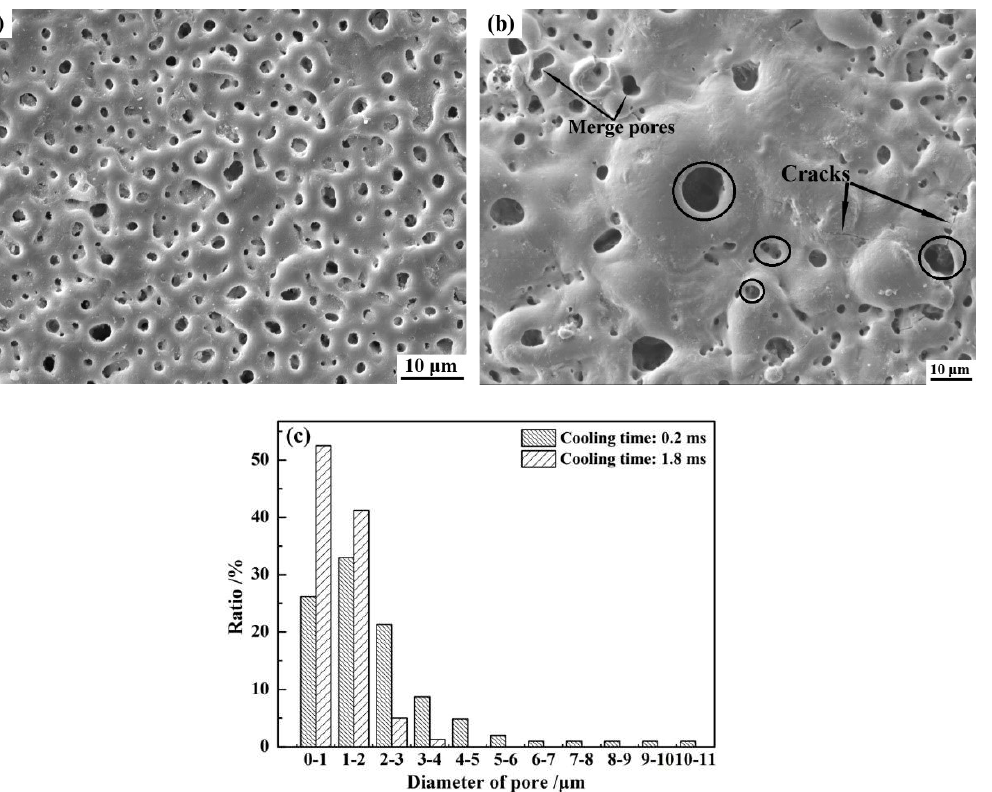
Figure 7. Surface morphology of the coatings when the cooling time is ( a ) 1.8 ms and ( b ) 0.2 ms and ( c ) distribution of pore diameter formed by MAO.